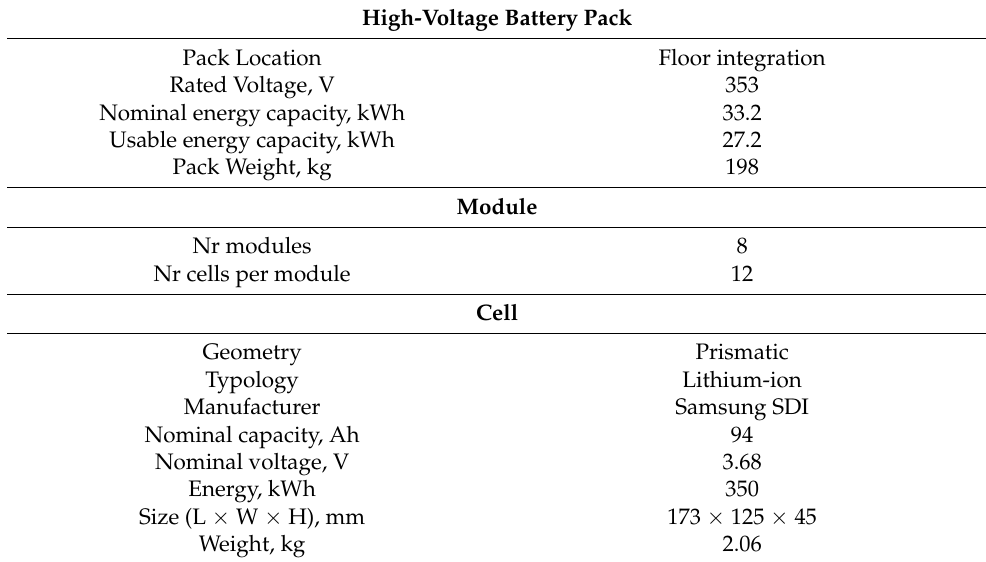
Table 2. Technical specifications of the battery pack for the commercial vehicle BMWi3 (94 Ah) Reproduced from [55], BMW 2016.